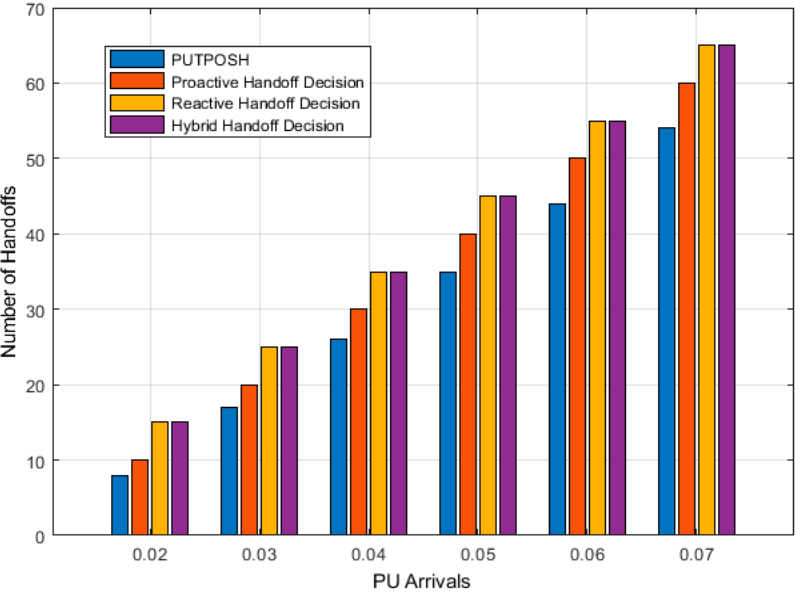
Figure 8. Comparison of PUTPOSH with the existing handoff schemes w.r.t. the number of handoffs.